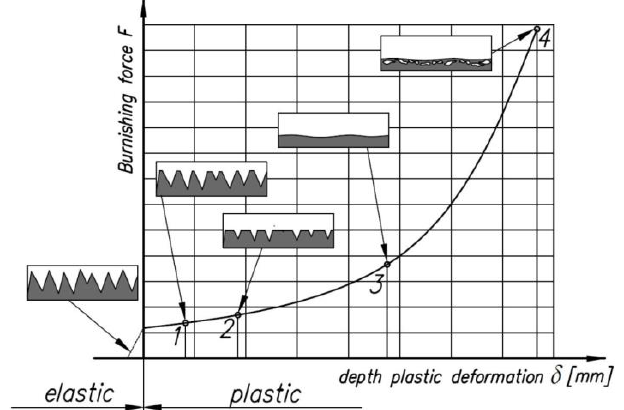
Figure 3. The effect of burnishing force on the deformation of surface asperities and the depth of the plastically deformed layer: 1 – flattening the roughness asperities, 2 – severe flattening of the surface topography, 3 – completely flattened surface, 4 – work hardened subsurface zone.